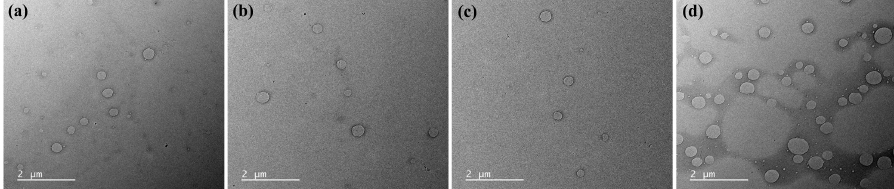
( d ) ICA (10  M)/β-CD-ALG. Scale bar: 2 